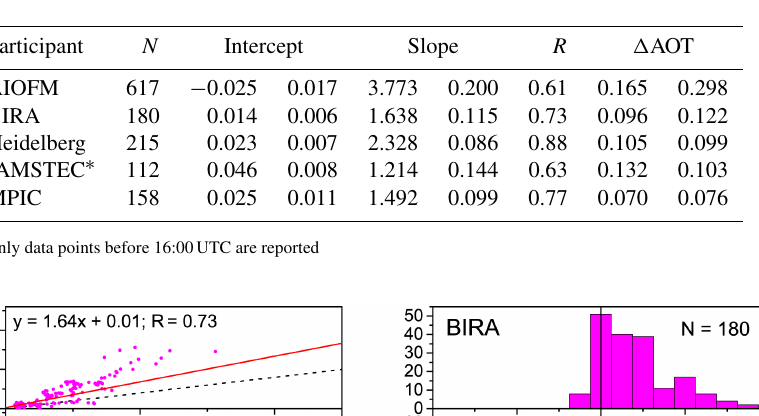
Table 3. Comparison between the surface extinction from MAX-DOAS and from WetNeph. Listed are the number of data points, intercept, and slope of the linear regression, the correlation coefficient R , the mean difference (MAX-DOAS minus WetNeph), and the standard deviation of the mean difference. All extinction values are in units of km − 1 .